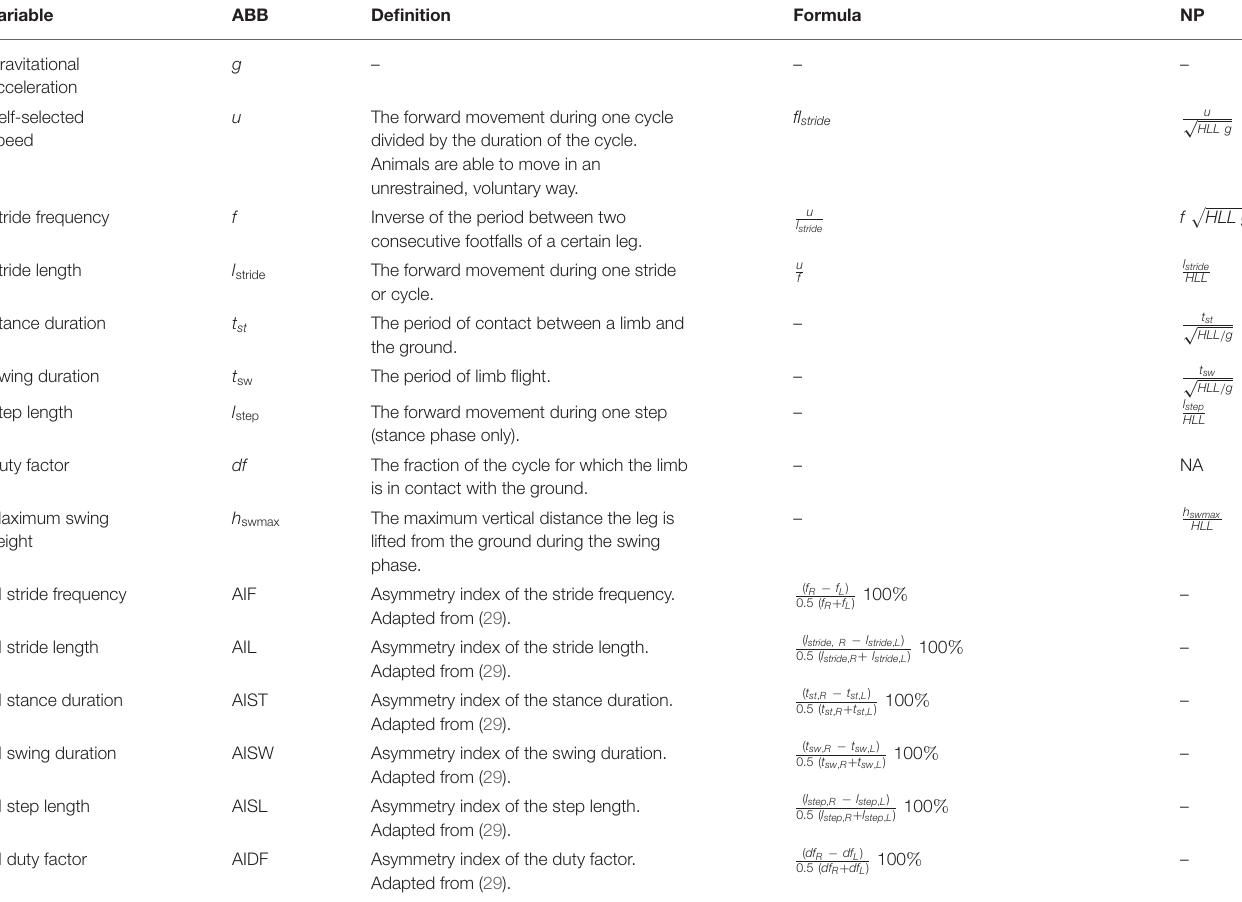
TABLE 1 | Summary of all used variables (abbreviations (ABB), definitions, and formulas, including normalization procedure [NP, adapted from (23)]. Variable ABB Definition Formula NP Gravitational acceleration Self-selected